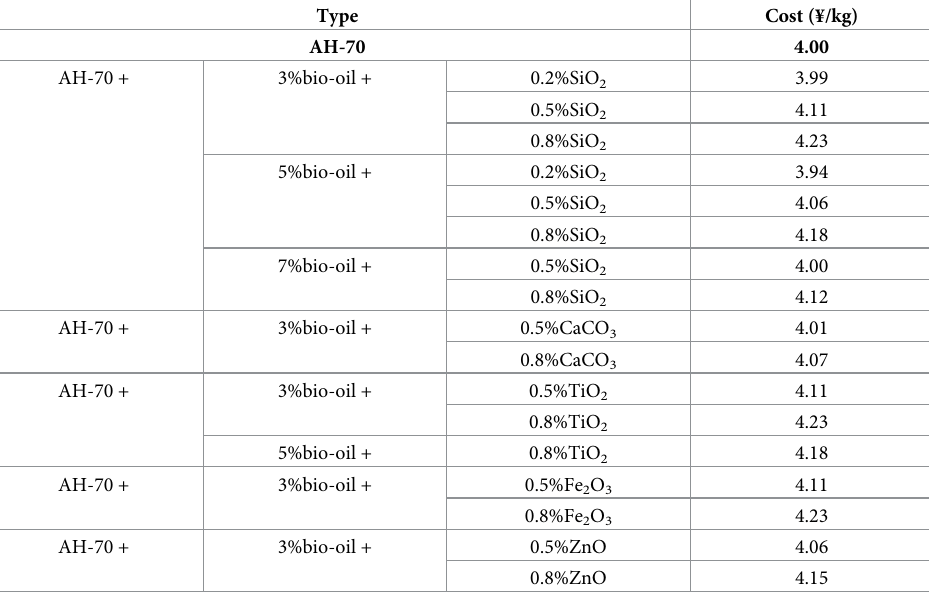
Table 10. Cost of the nano-modified bio-asphalt